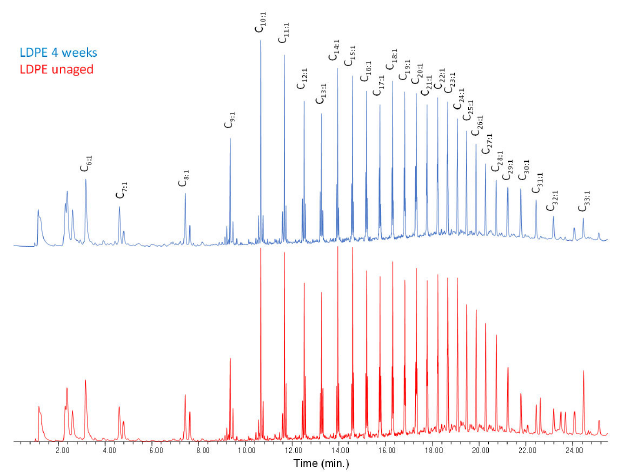
Figure 19. Chromatograms obtained in the Py–GC–MS analysis of the extraction residues of the LDPE-0w (red) LDPE-4w (blue). The complete list of the main pyrolysis products is reported in Table S17 in the Supplementary